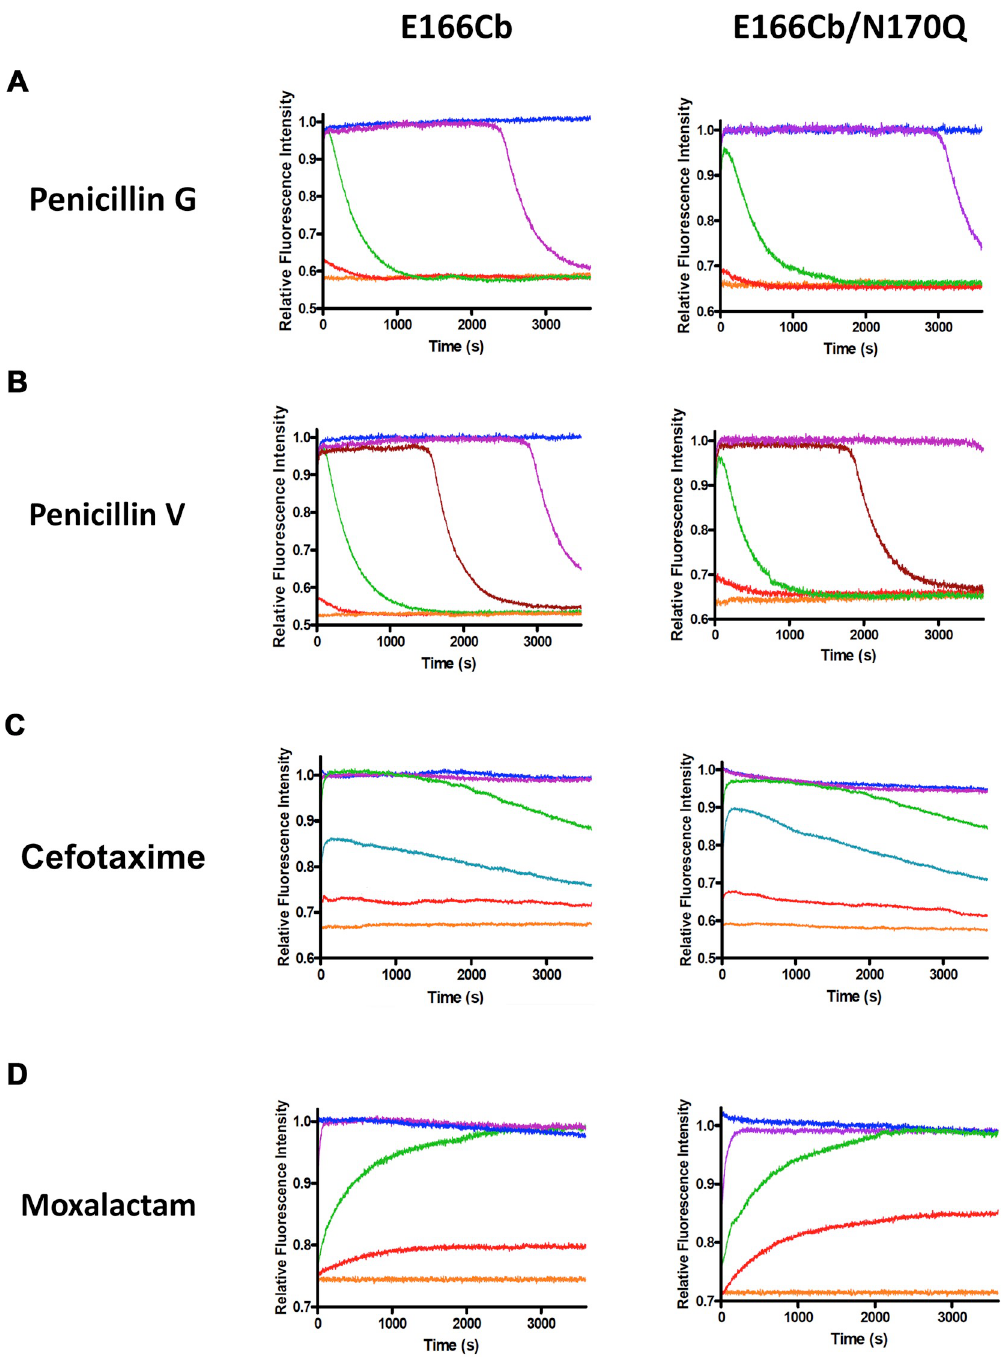
Fig 3. Fluorescence detection of β -lactam antibiotics by BADAN-conjugated β -lactamases, E166Cb and E166Cb/N170Q. Fluorescence traces were acquired after adding 0.1 μ M labeled enzyme with (A) penicillin G, (B) penicillin V, (C) cefotaxime and (D) moxalactam in 50 mM potassium phosphate buffer (pH 7.0). Antibiotic concentrations: 0 (orange), 10 nM (red), 50 nM (cyan), 0.1 μ M (green), 0.5 μ M (brown), 1 μ M (purple) and 10 μ M (blue). Fluorescence measurements were conducted several times with similar results. Representative traces were